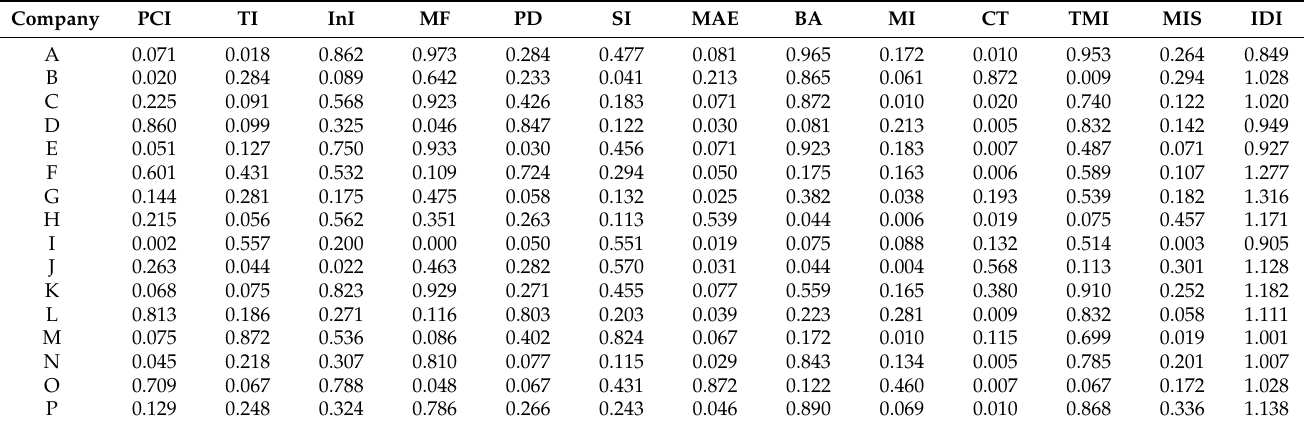
Table 6. Results of integrated development of companies under the replication